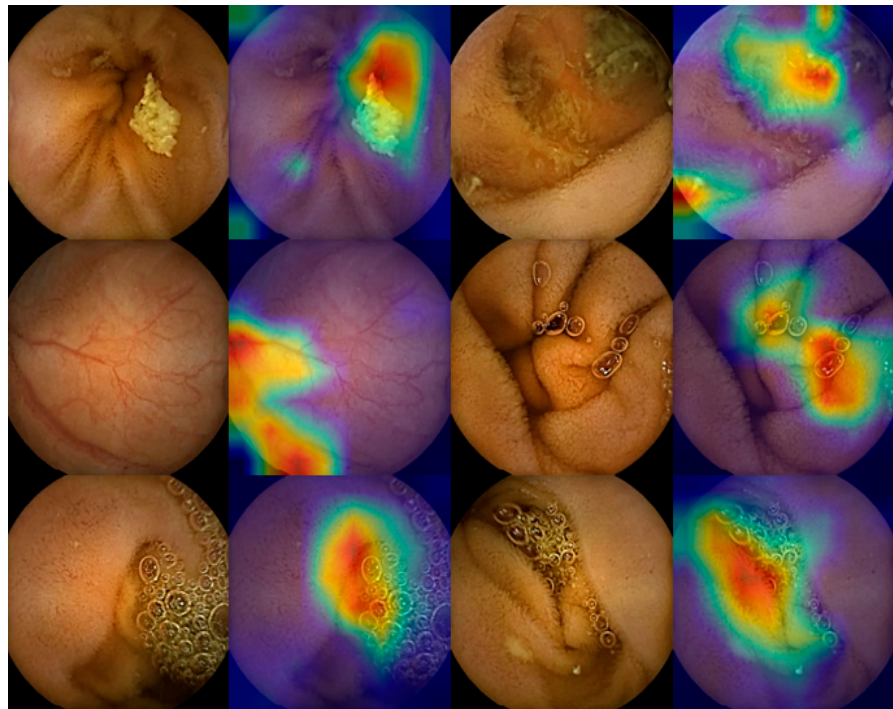
Figure 1. Examples of detection error in the binary classification of artificial intelligence (AI) reading . The bile, vascular structure, bubble, and normal mucosal fold were mistaken for significant lesions in AI reading.